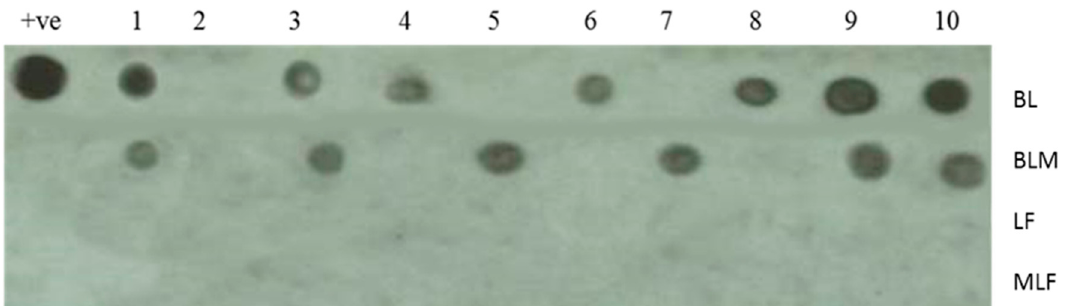
Figure 3. Detection of PVY in the leaves of treated potato plants using dot blot hybridization technique in the leaves of potato cultivated under open field conditions and treated once with 500 μ g mL − 1 (15 days after the viral infection) of BL and LF or BLM and MLF. The numbers from 1 to 10 refer to different potato plant samples of the same treatment and + ve is the positive control. The negative control was run separately and did not show any spot (data not shown). Ten representative plant samples out of a total of 15 plants/treatment were randomly selected and used in this analysis. Using RT-PCR, the data in Figure 4 confirm the data obtained by DAS-ELISA and dot-blot hybridization that the modified proteins generally have enhanced antiviral action against potato virus PVY, more than their native forms, except LF, which is highly active in its native form. Both LF and MLF achieved 100% viral elimination, against 60% in the case of BLM.